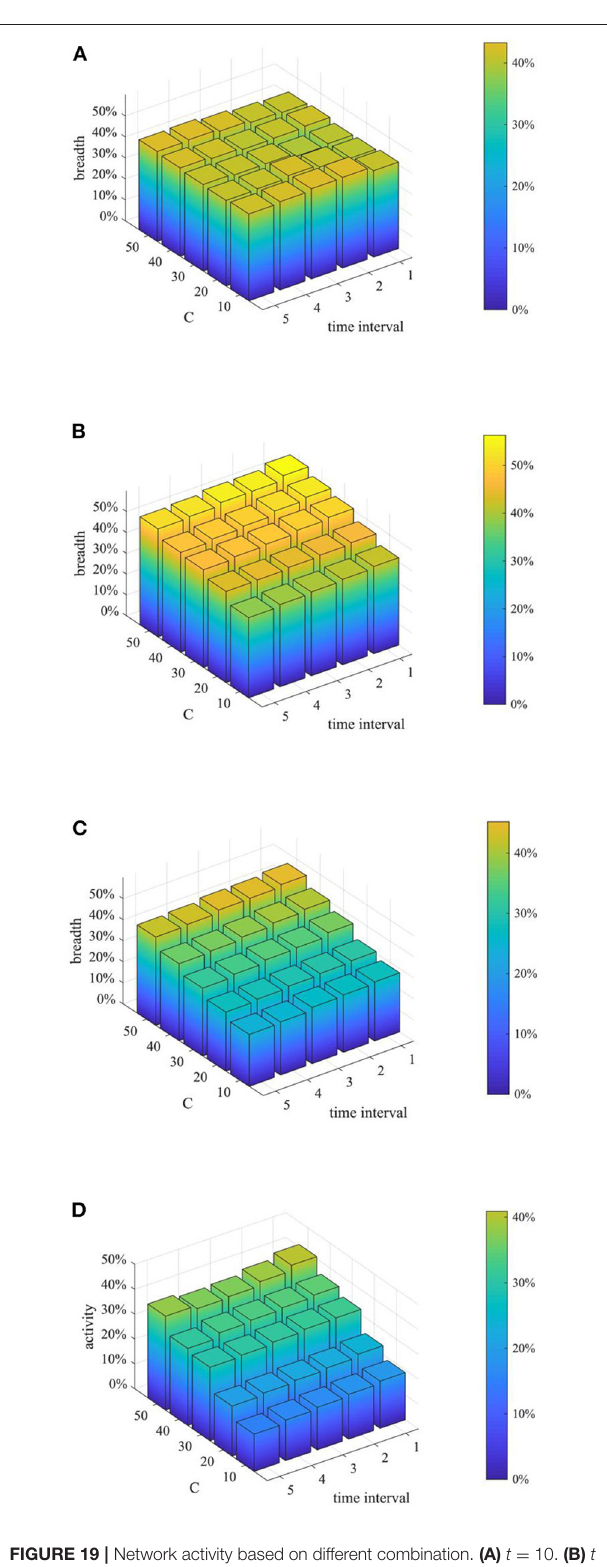
FIGURE 19 | Network activity based on different combination. (A) t = 10. (B) t = 20. (C) t = 30. (D) t =